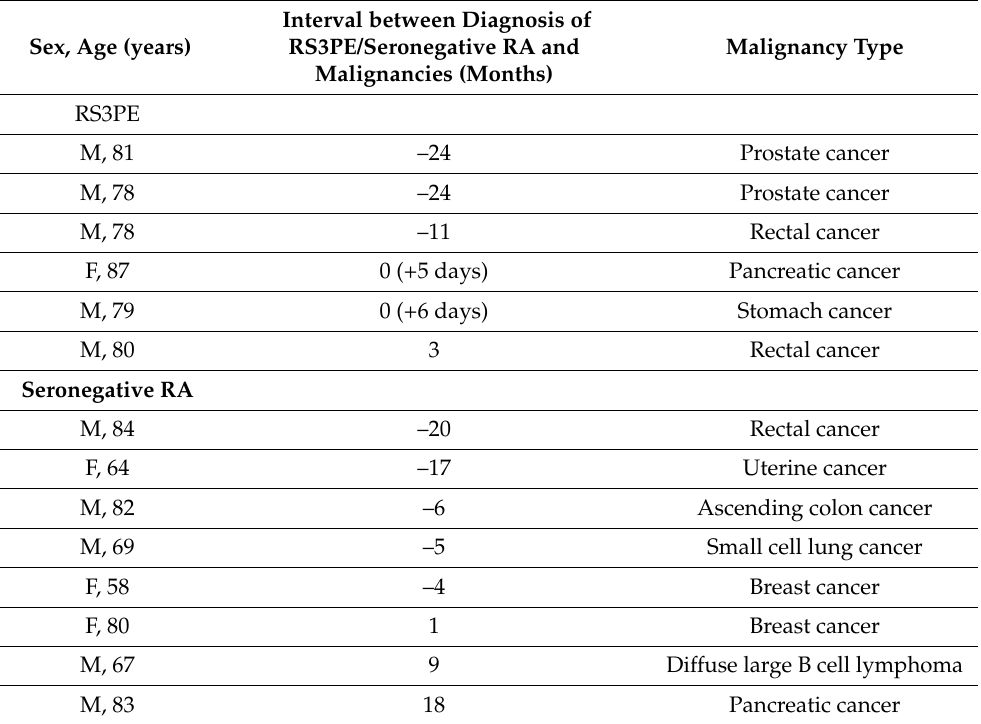
Table 2. Patients with malignancies 2 years before and after RS3PE or seronegative RA